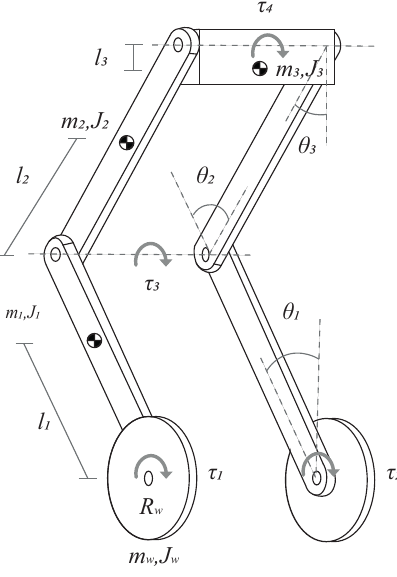
Figure 1. Diagram of an underactuated mobile robot with five degrees of freedom.